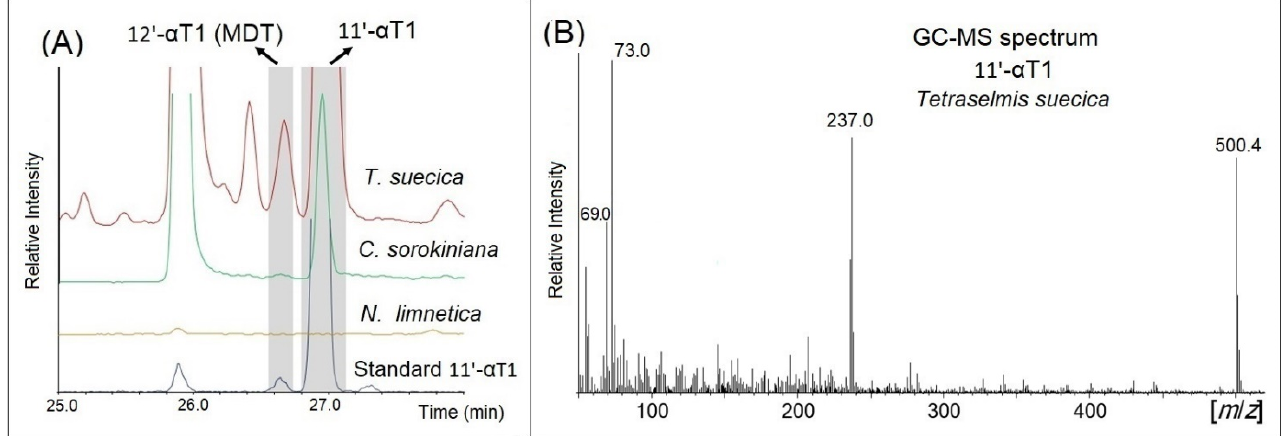
Figure 3. Identification of 11 ′ - α -tocomonoenol (11 ′ - α T1) in Chlorella sorokiniana , Nannochloropsis limnetica , and Tetraselmis suecica. GC-MS chromatograms of C. sorokiniana , N. limnetica , T. suecica , and 11 ′ - α -tocomonoenol (11 ′ - α T1) standard showing the corresponding peaks of 12 ′ - α -tocomonoenol (12 ′ - α T1) and 11 ′ - α -tocomonoenol (11 ′ - α T1) ( A ) and representative GC-MS spectrum obtained for peak 11 ′ - α -tocomonoenol (11 ′ - α T1) in T. suecica ( B ) . Tocochromanol profiles of Chlorella sorokiniana , Nannochloropsis limnetica , and Tetraselmis suecica cultured in Germany were obtained by HPLC-FLD and show low but quantifiable amounts of α T1 in C. sorokiniana and T. suecica (Table 2), corresponding to 0.1% and 0.9% of the total tocochromanol content in these species, respectively (Figure 4A). α T1 was not detected in N. limnetica by HPLC-FLD; therefore, its concentration must be below the corresponding limit of quantification ( < 0.09 mg/kg DW). Table 2. Tocochromanol profiles of Chlorella sorokiniana , Nannochloropsis limnetica , and Tetraselmis suecica determined by HPLC-FLD. Values are arithmetic mean ± standard deviation; n = 6. Conge- ners not sharing a superscript letter are significantly different (ANOVA, α = 0.05). Congener